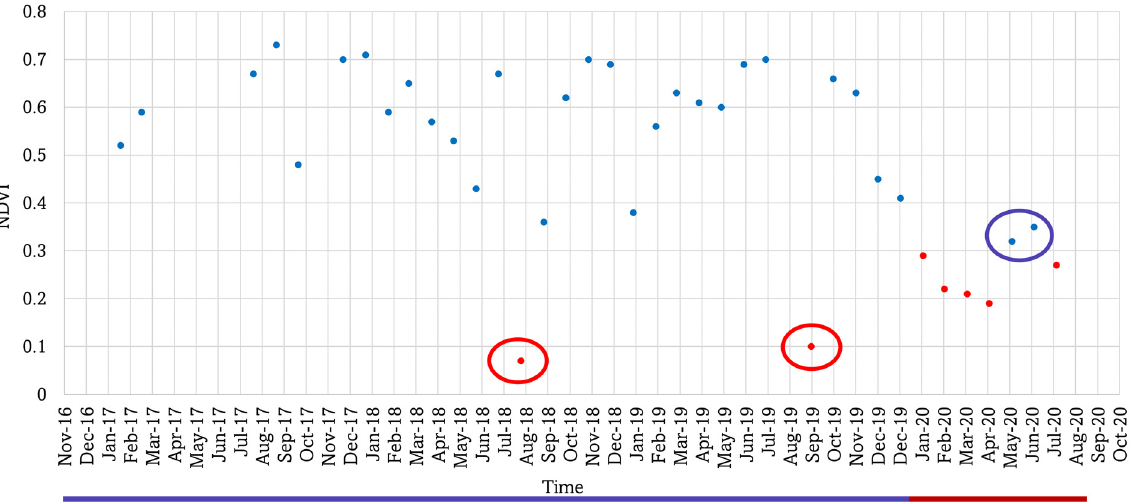
Figure 10. NDVI Time-Series Representative Plot ID148—Mangrove Stage Changes Using Rule-based Methodology Healthy to Degradation; The Circled Showed Some NDVI of Each Mangrove Stage Did Not Follow NDVI Rule-Based on Time-series Data.